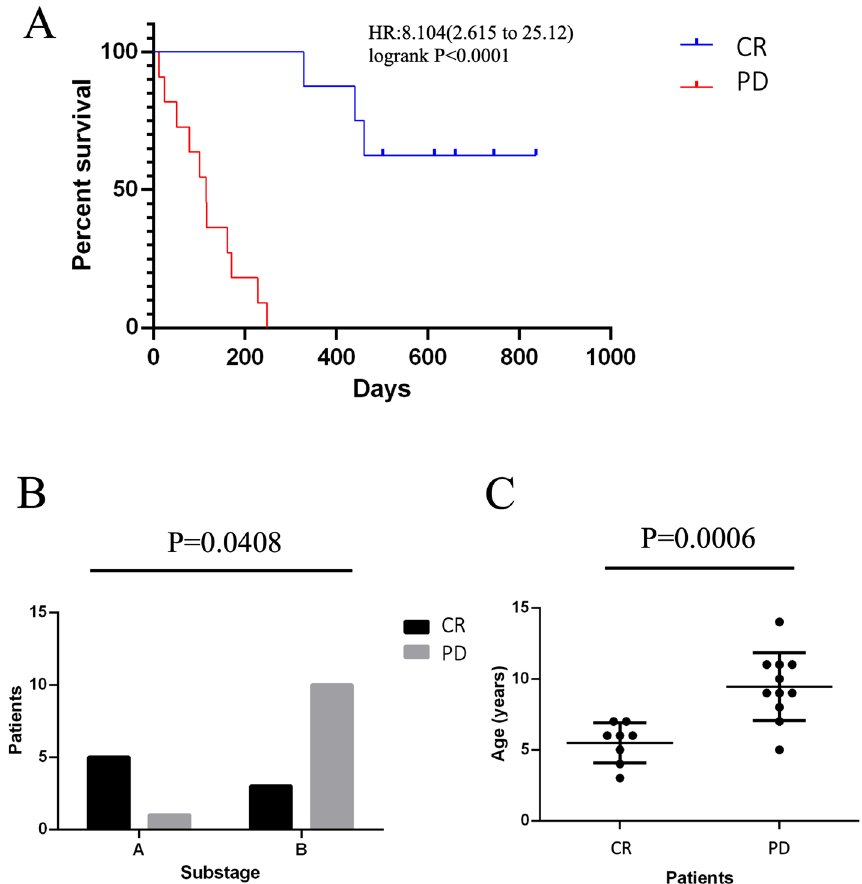
Figure 1. Therapeutic response of lymphoma patients and clinical differences between the group of complete response (CR) and the group of progressive disease (PD). ( A ) Survival proportions of groups CR and PD ( P < 0.0001), Censored patients (alive dogs) are indicated on the Kaplan–Meier curve as tick. ( B ) Frequency of substages A and B in CR and PD groups ( P = 0.0408). ( C ) Mean age between groups CR and PD ( P =